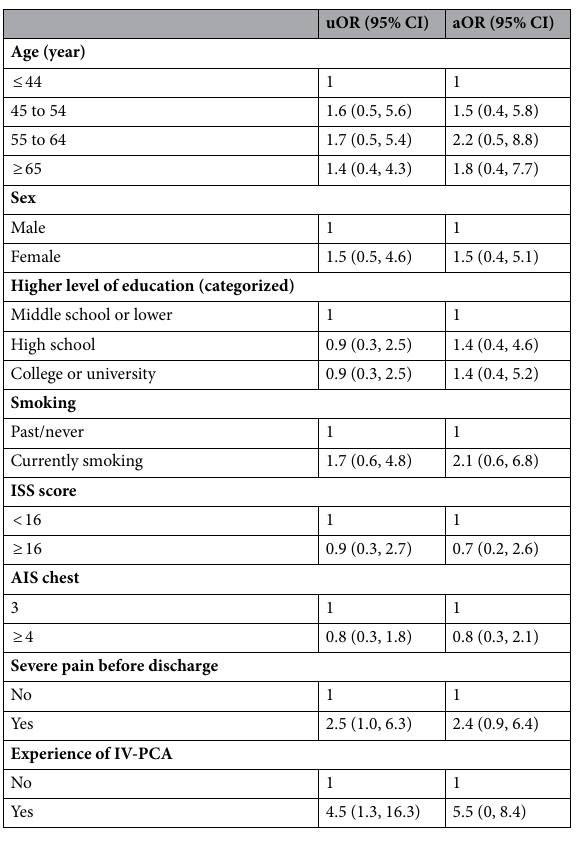
Table 3. Factors associated with chronic post-thoracotomy pain after traumatic multiple rib fractures (n = 99). Values of unadjusted estimates are from bivariate analysis between each factor and presence of moderate to severe chronic pain. uOR: unadjusted odds ratio; aOR: adjusted odds ratio; CI: confidence